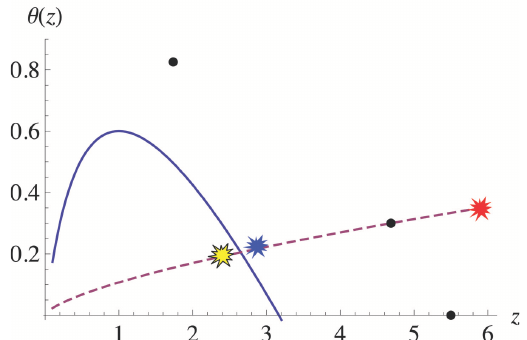
Figure 15. Instability region (inside the solid line boundary) for the model of nuclear-drop-like object with equation of state with nuclear-fog interpolation [80]. Inside the region, V 2 s < 0; outside the region, V 2 s > 0. On the ( θ , z )-graph, pressure points p = 0 (for the same cases as illustrated in Figures 13 and 14) are shown as black dots—their coordinates are ( 5.5,0 ) , ( 4.7,0.3 ) , and ( 1.74,0.83 ) . Any process that cools and/or decompresses the stellar fragment from its initial mono-phase state ( z 0 , θ 0 ) into the state of nuclear-fog (within the unstable spinodal zone) can trigger development of collective instability and fragmentation within the nuclear matter. Adiabatic line θ = θ 0 ( z / z 0 ) 2/3 is drawn to guide the eye. Red, blue, and yellow stars represent stages of stellar fragment evolution: red—“hot” state after its birth, blue—“cool” state at the time of encounter with an obstacle, yellow—“nuclear-fog” (explosive) stage localized by internal wave of decompression during deceleration caused by the